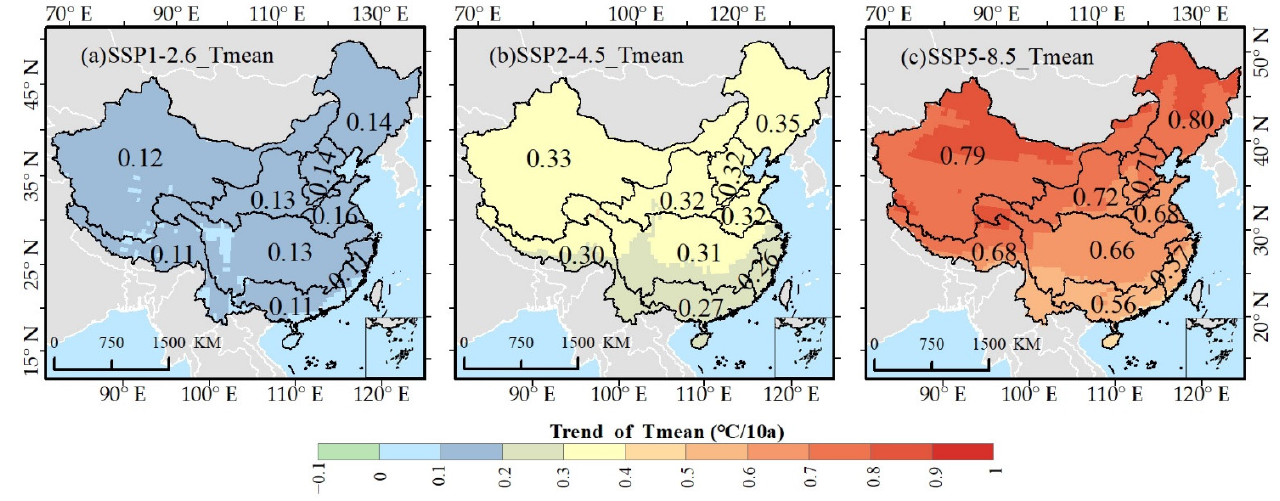
Figure 6. Spatial distribution of the trend of T mean in mainland China under ( a ) SSP1-2.6, ( b ) SSP2-4.5, ( c ) SSP3-8.5 scenarios from 2021 to 2100 based on MME.